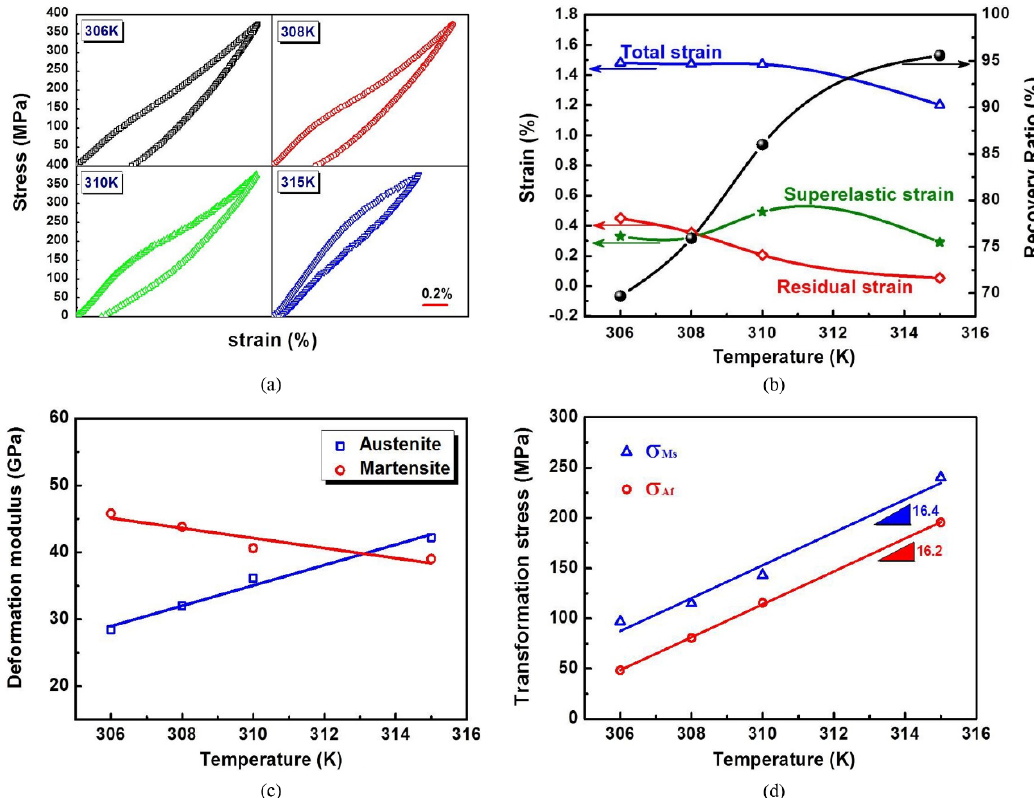
Mn Ga Fe 48 26.4 19.7 5.9